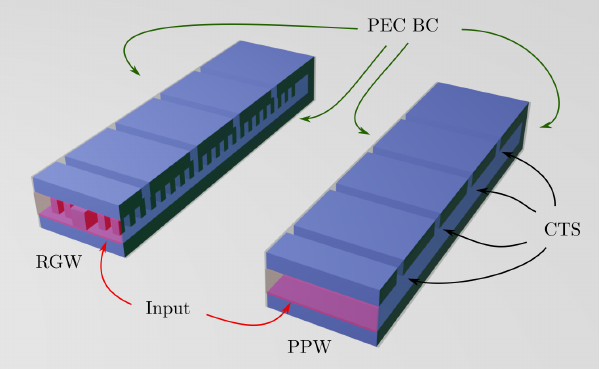
Figure 3. Comparison between a single ridge exciting a column of CTSs ( left -hand figure) and a PPW design ( right -hand figure), both with lateral PEC boundary conditions.